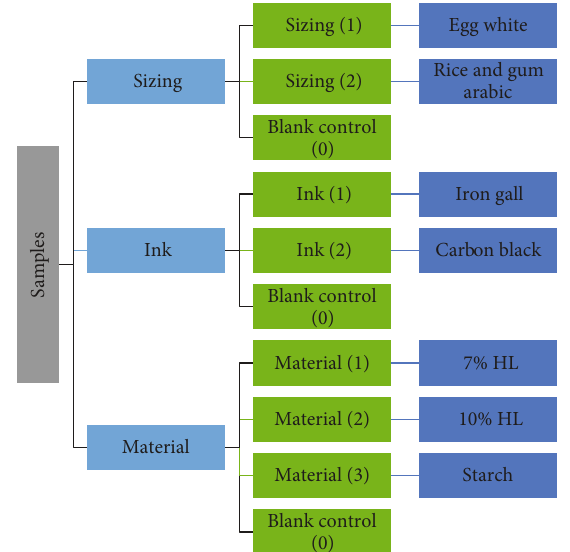
Figure 2: Schematic diagram for the preparation of paper samples.